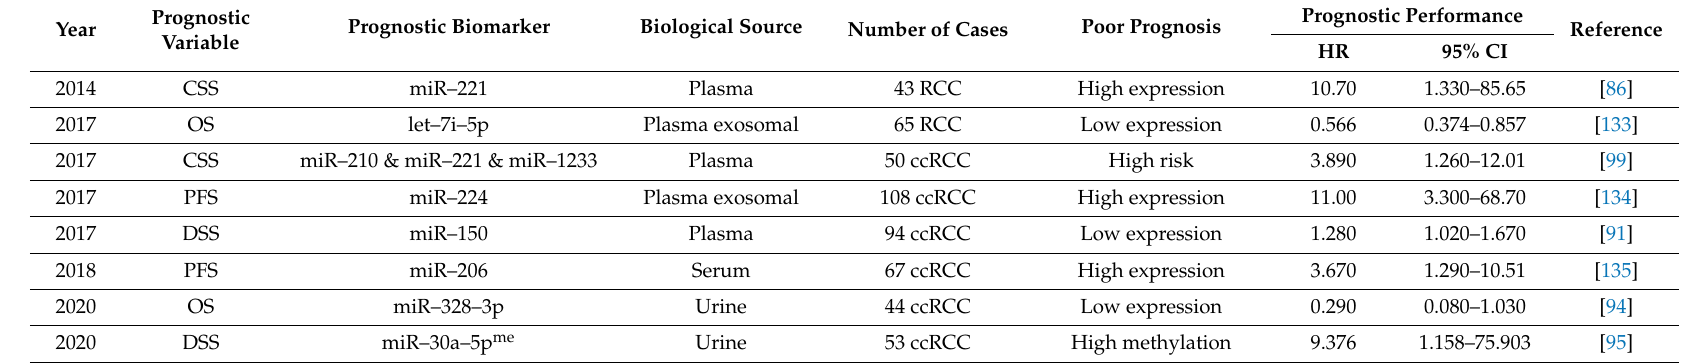
Table 4. Prognostic small non-coding RNAs (sncRNAs) for RCC in liquid biopsies.